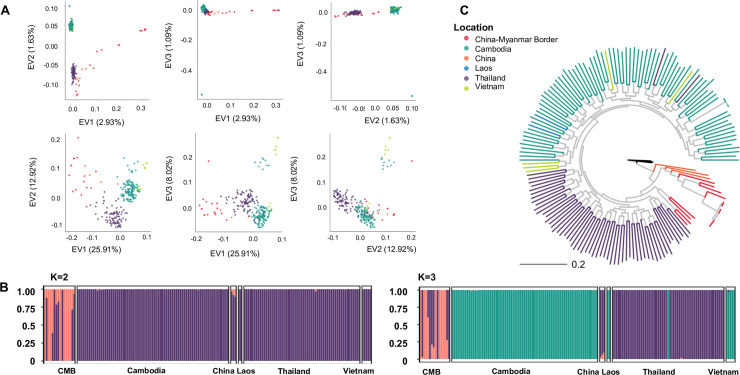
Population structure of P. vivax within the GMS.A) PCA using SNPs from the entire genome (top panel) or from 36 SNPs with the top Fst values which are not in LD (bottom panel) B) Admixture analysis using models where k = 2 (left) or k = 3 (right) and each predicted population is denoted by a separate coloration. C) Maximum-likelihood tree of monoclonal samples from across the GMS predicted in RAxML. Black lines denote an outgroup from Madagascar.